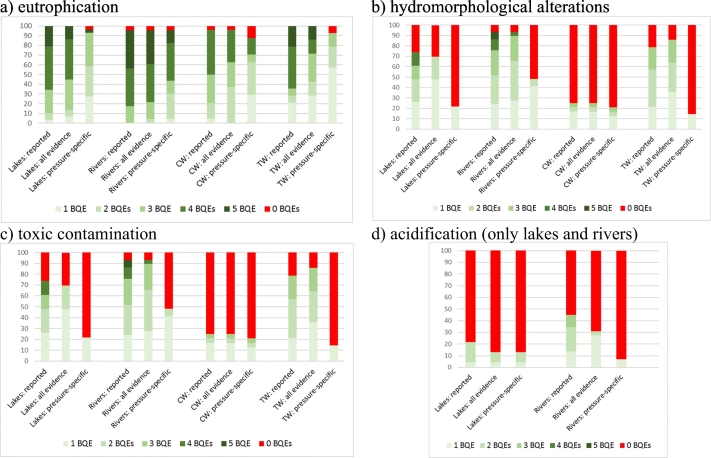
Number of Biological Quality Elements (BQEs) in national classification systems for lakes rivers, coastal (CW) and transitional waters (TW) sensitive for different pressures: (1) as reported by member states; (2) supported by some evidence (Table 1: Category A + B + C); (3) supported by pressure-specific evidence (Table 1: Category A). Y-axis shows the percentage of the total number of countries with relevant water bodies.